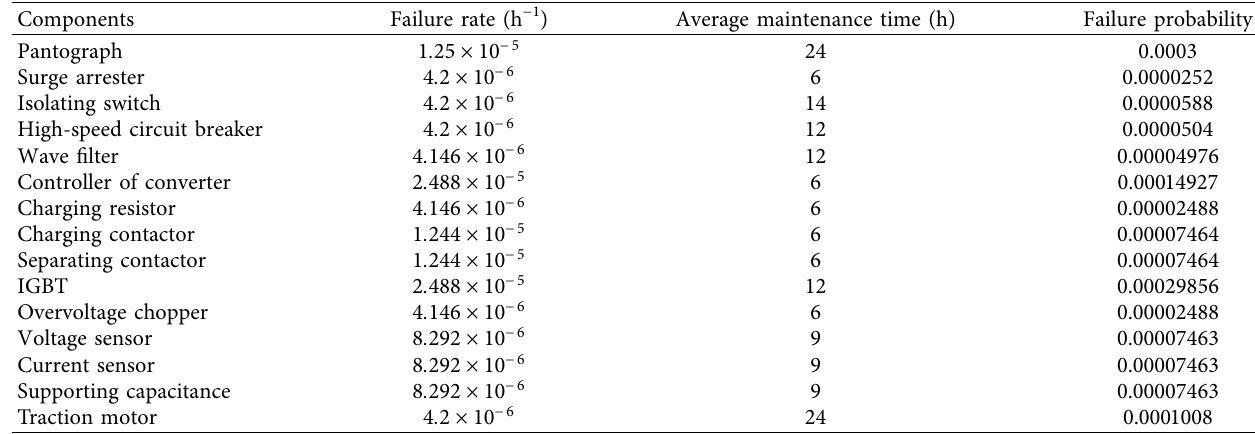
Table 1: Reliability parameters of the